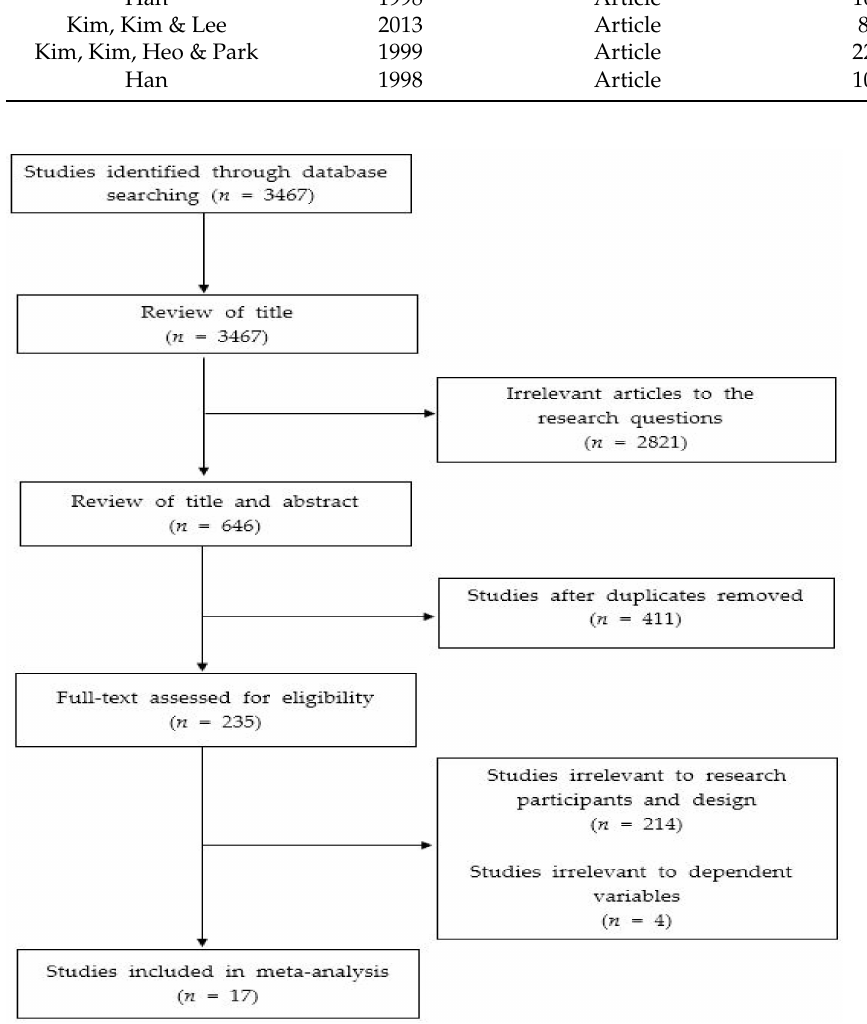
Figure 1. PRISMA flow